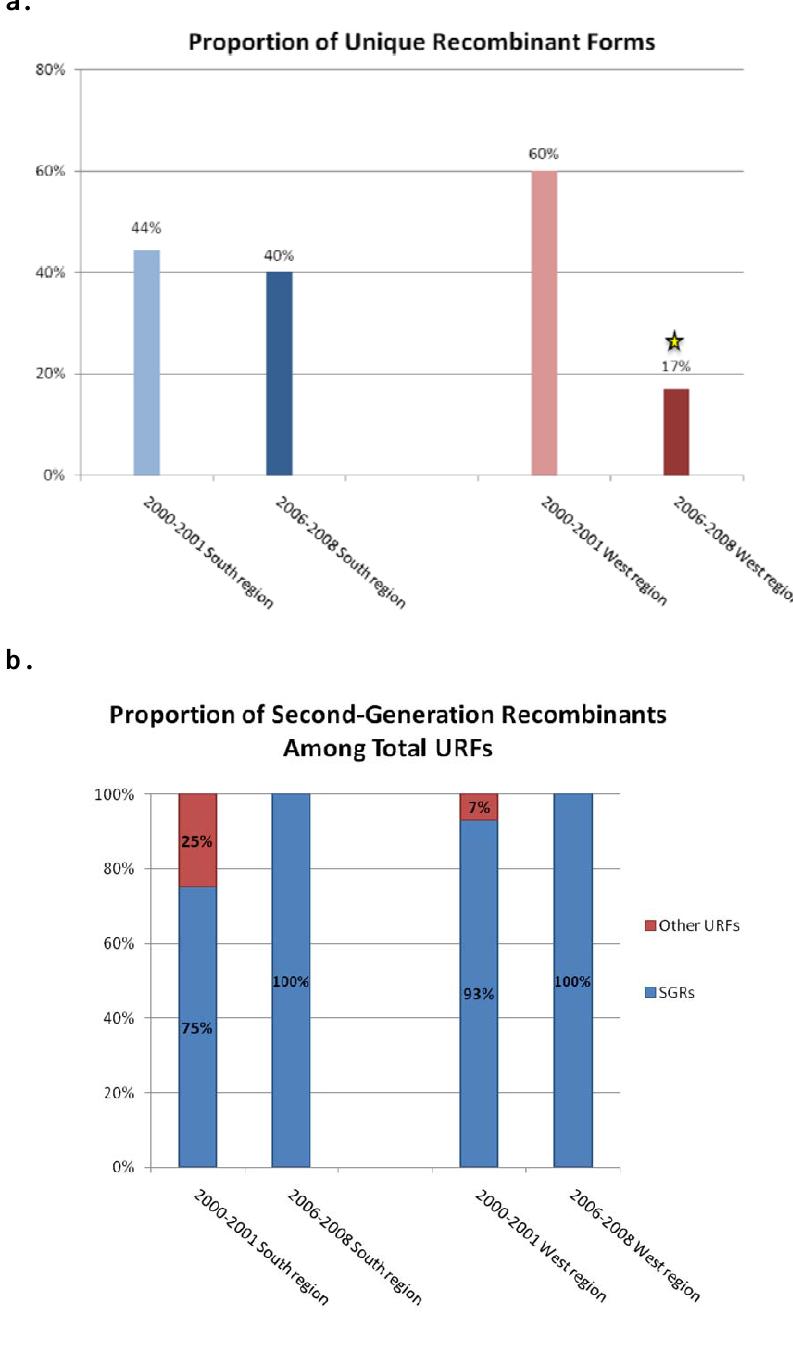
Figure 4. Proportion of Unique Recombinant Forms (URFs) and Second-Generation Recombinants (SGRs), South and West regions. (a) Percentages of URFs among total specimens. (b) Percentages of SGRs among total URFs. Statistically significant decrease (p < 0.05) is denoted by an